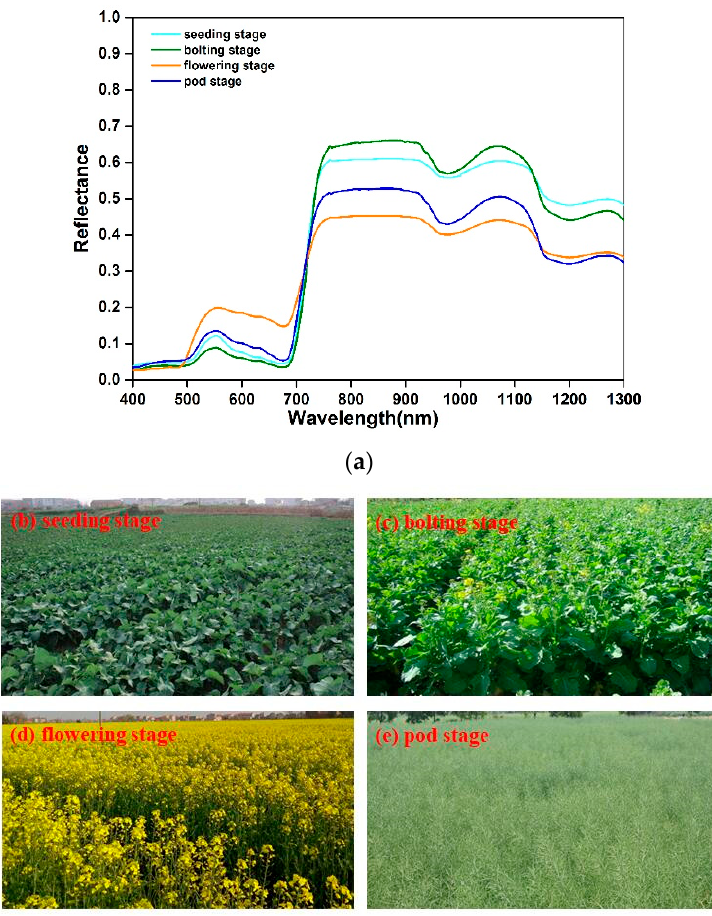
Figure 2. Canopy spectral reflectance and field pictures at four different stages. ( a ) Canopy spectral reflectance at seeding, bolting, flowering and pod stages; ( b ) Field picture at seeding stage; ( c ) Field picture at bolting stage; ( d ) Field picture at flowering stage; ( e ) Field picture at pod stage.